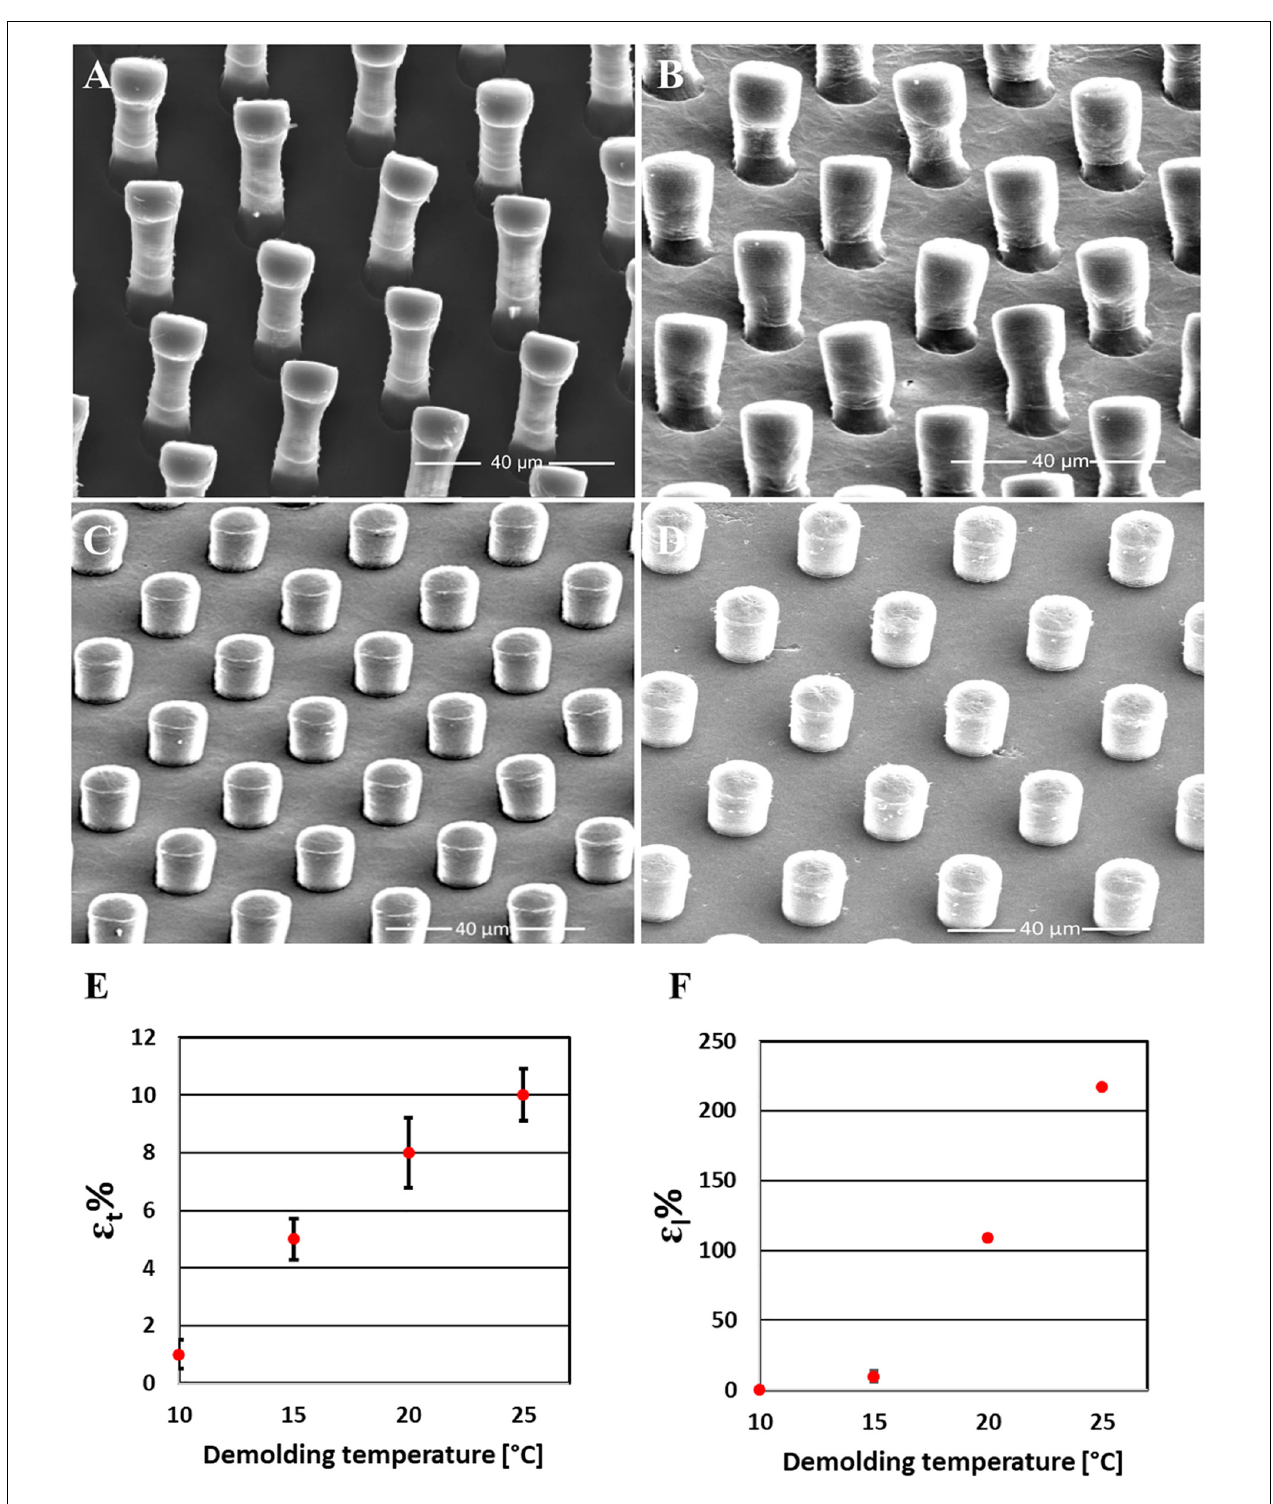
FIGURE 4 | Measurements of the pillars elongation as a function of the demolding temperature. SEM images of PCL scaffolds detached from the mold at 25 ◦ C (A) , 20 ◦ C (B) , 15 ◦ C (C) , and at 10 ◦ C (D) ; Quantification of transverse (E) and longitudinal deformation (F) of the pillars {The deformed height (Hd) and width (Wd) of the pillars fabricated by using different demolding temperatures were measured from SEM images and compared with the nominal height and width of the pillars. The longitudinal deformation in percentage ( ε l%) was calculated by [(Hd-Hi)/Hi] × 100 and the transverse deformation in percentage ( ε t%) was calculated by [(Wd-Wi)/Wi] ×